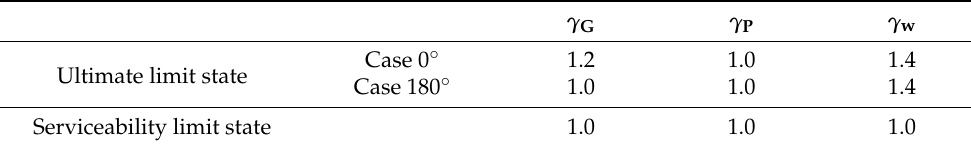
Table 3. Design coefficient of the structure